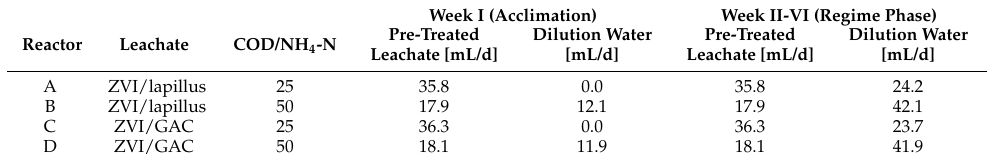
Table 3. Semicontinuous reactors’